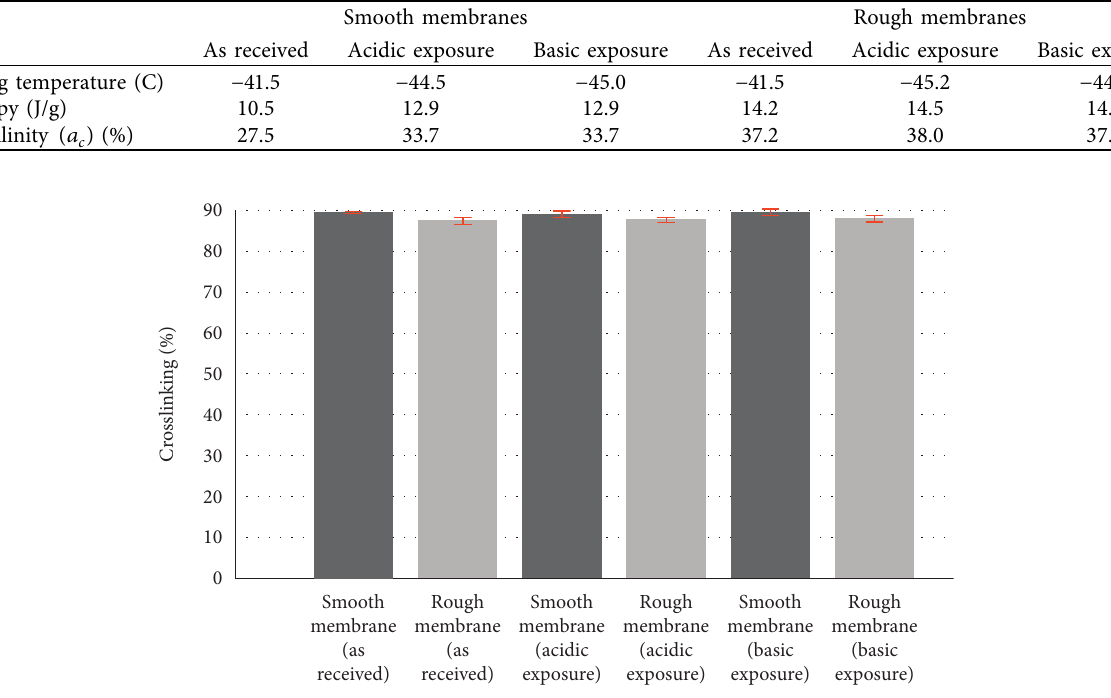
Figure 6: Percentage of crosslinking for smooth and rough breast implant membranes. Table 2: Crosslinking for samples as received and after acidic and basic